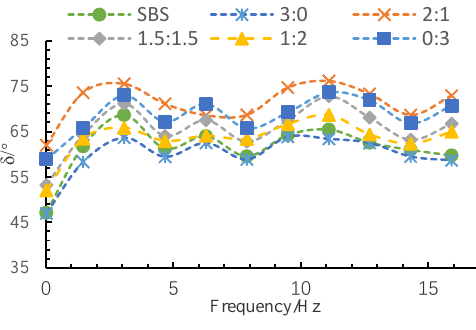
Figure 11. Test results of phase angle.